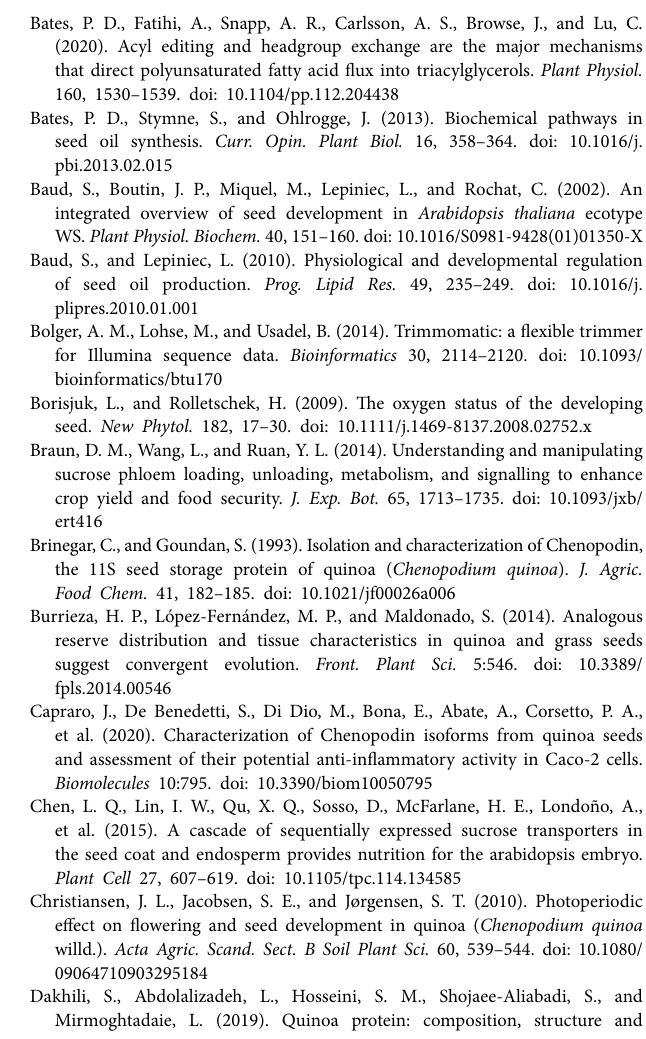
Supplementary Table S3 | List of the 999 transcripts in quinoa seeds showing at least eight times higher/lower expression from the comparison of Pasankalla as compared to Regalona and Titicaca with the expression values (estimated raw read counts) in biological replicates, log2fold changes, and the functional annotations of transcripts. Of these, 60 transcripts were encoding either transcription factors, functions involved in central carbon metabolism of starch, sugar, protein and oil, or genes known to regulate embryo size which can be found in a separate folder. Supplementary Table S4 | Gene ontology (GO) term enrichment analysis of the 3,568 DETs found to be differentially expressed in Pasankalla as compared to Regalona and Titicaca. The 60 candidate genes ( Figure 8 ) could be associated to 24 of the 48 GO terms listed and are marked in yellow. Supplementary Table S5 | List of the 2,863 SNPs/INDELs of high to moderate impact variants identified in the 3,072 DETs found in Pasankalla as compared to in Titicaca and Regalona. Of these SNPs/INDELs, the ones localized to the 60 selected target transcripts are shown in a separate folder. Supplementary Table S6 | List of all differentially expressed transcripts (DETs) (from Table 1 ) in quinoa seeds from all one-against-two and pair-wise genotype comparisons. The table contains the expression values (estimated raw read counts) in three biological replicates, log2fold changes (with cutoff FDR<1e-2 and log2FC is set to 1), and the functional annotations of